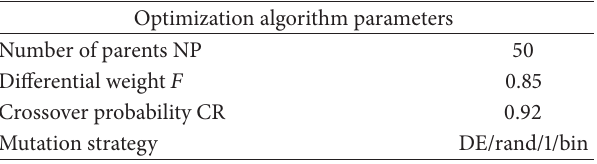
Table 6: Parameters of DE-optimization algorithm.